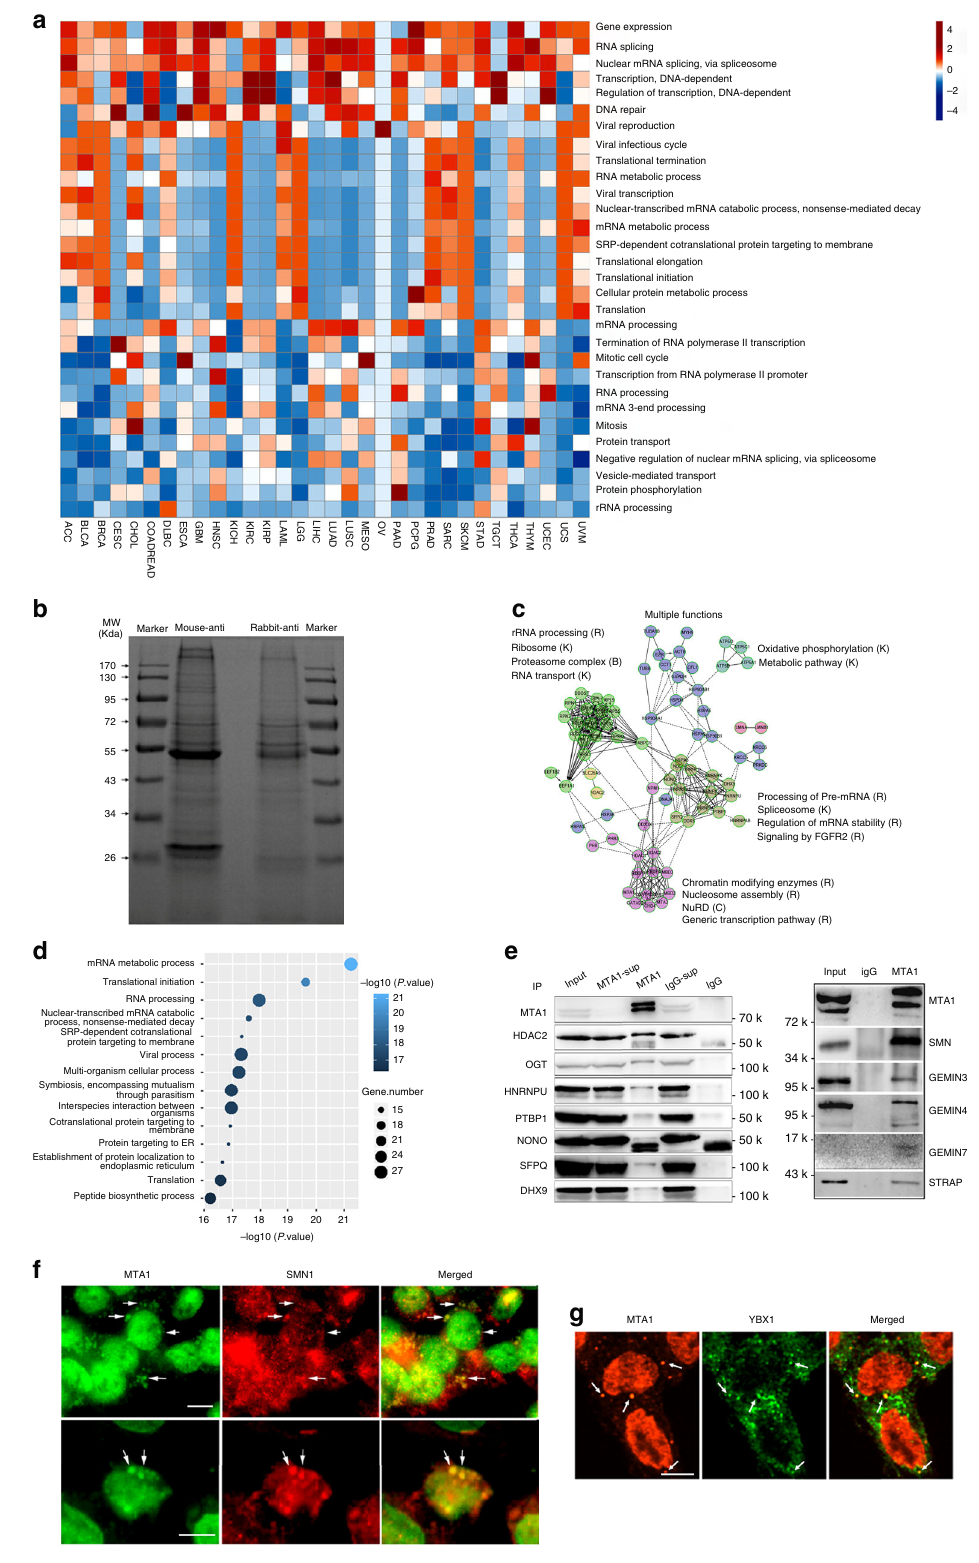
complex in HCT116 cells (Fig. 2a). MTA1-fCLIP reads were extensively distributed in the genic regions after mapping to the human genome (GRCH38) by TopHat2 19 , indicating a global association of MTA1 with transcripts (Supplementary Fig. 2a). MTA1-fCLIP reads occupied dominantly the CDS